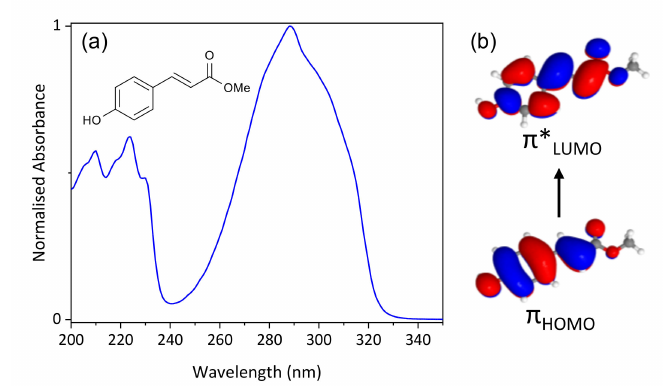
Figure 1. ( a ) UV absorption spectrum of para -hydroxy methylcinnamate ( p -HMC) (structure shown inset) in cyclohexane. ( b ) p -HMC’s π highest occupied molecular orbital ( π HOMO ) and π * lowest unoccupied molecular orbital ( π * LUMO ) relating to the S 1 ( ππ *) state.